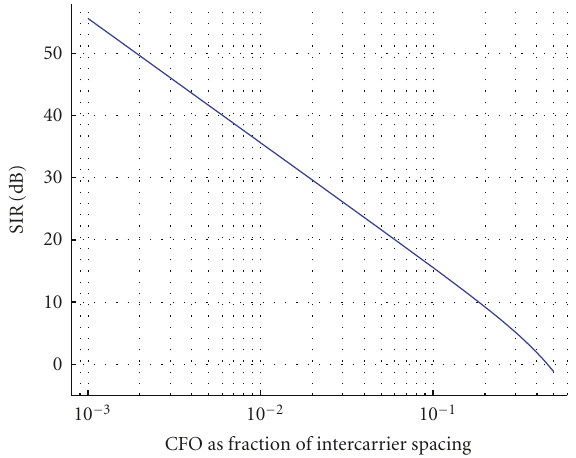
Figure 7: SIR as function of mobility. Obtained from (23) with no carrier frequency o ff set (CFO), SNR Γ = ∞ and system parameters are as in Figure 1. Selected SIR levels due to CFO are also given for comparison ( × -markers, values copied over from Figure